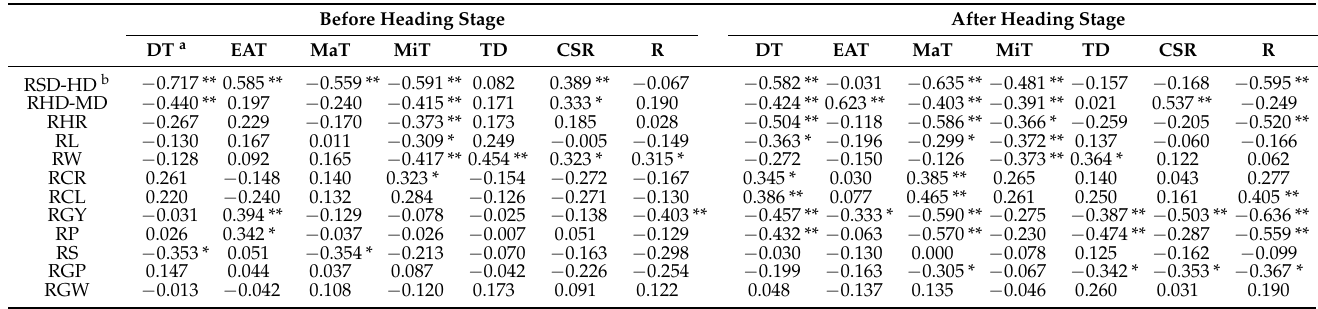
Table 2. Correlation of growth duration, grain yield- and quality-related traits with temperature and solar radiation before heading stage and after heading